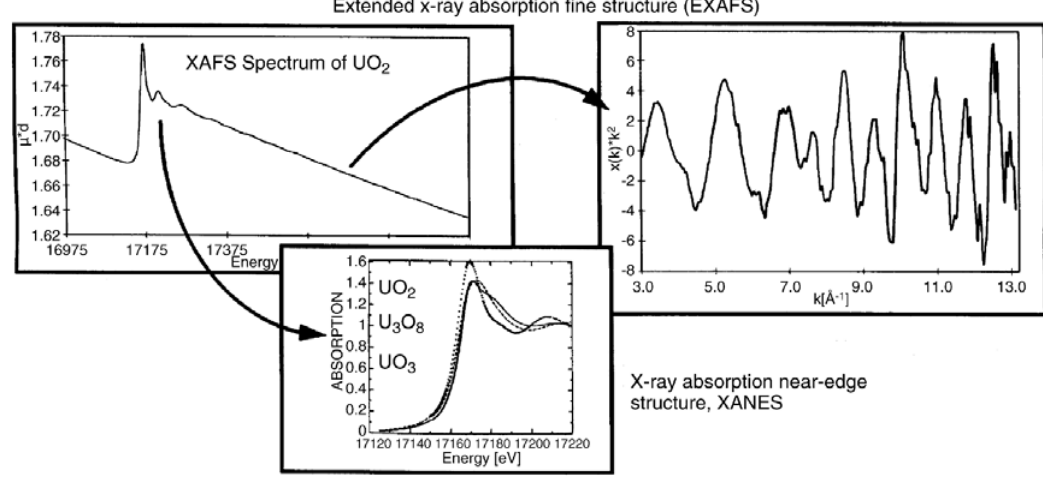
-edge XAFS spectrum of UO (s). The k 3 -weighted EXAFS III 2 O and UO 3 8 3